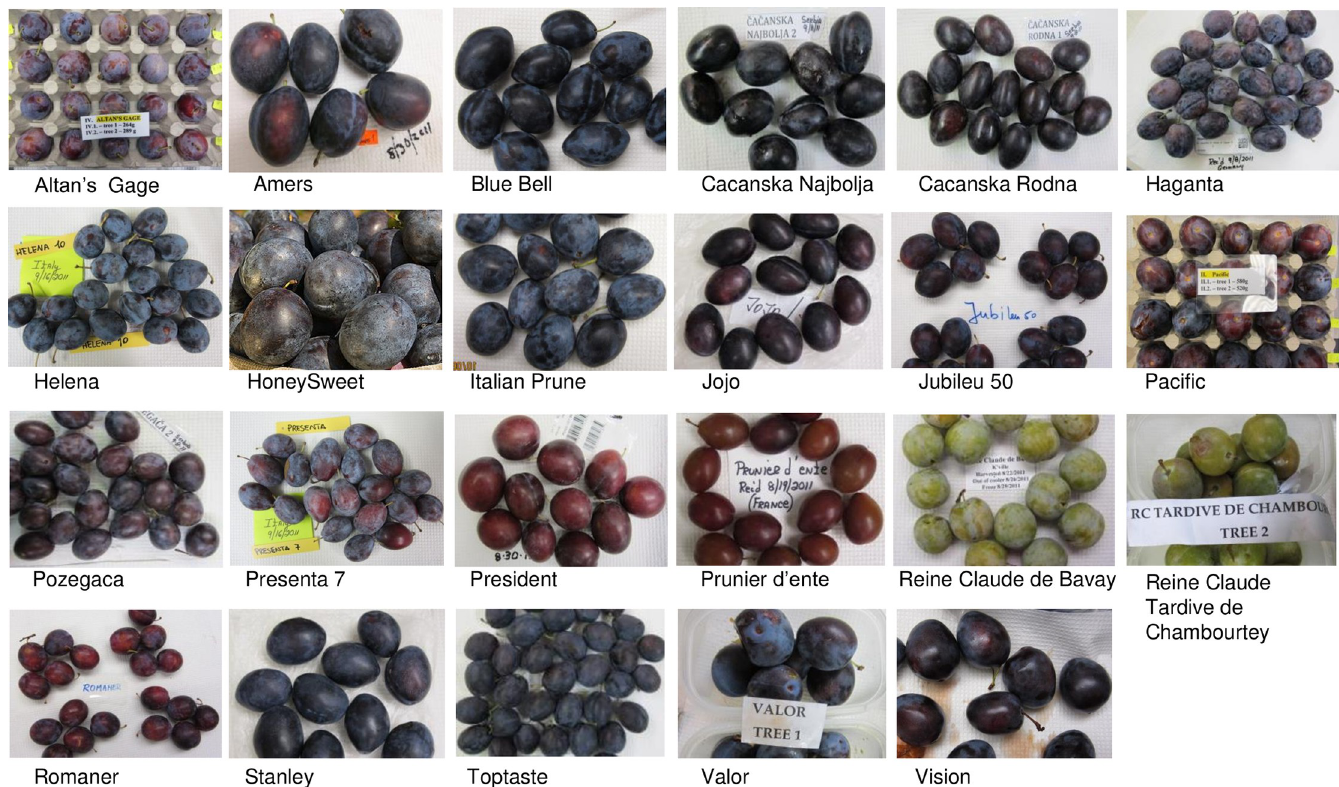
Fig 1. Composite of all the plums used in the composition analyses. Picture of the fruit as it was received. ‘HoneySweet’ picture is from previous fruit.